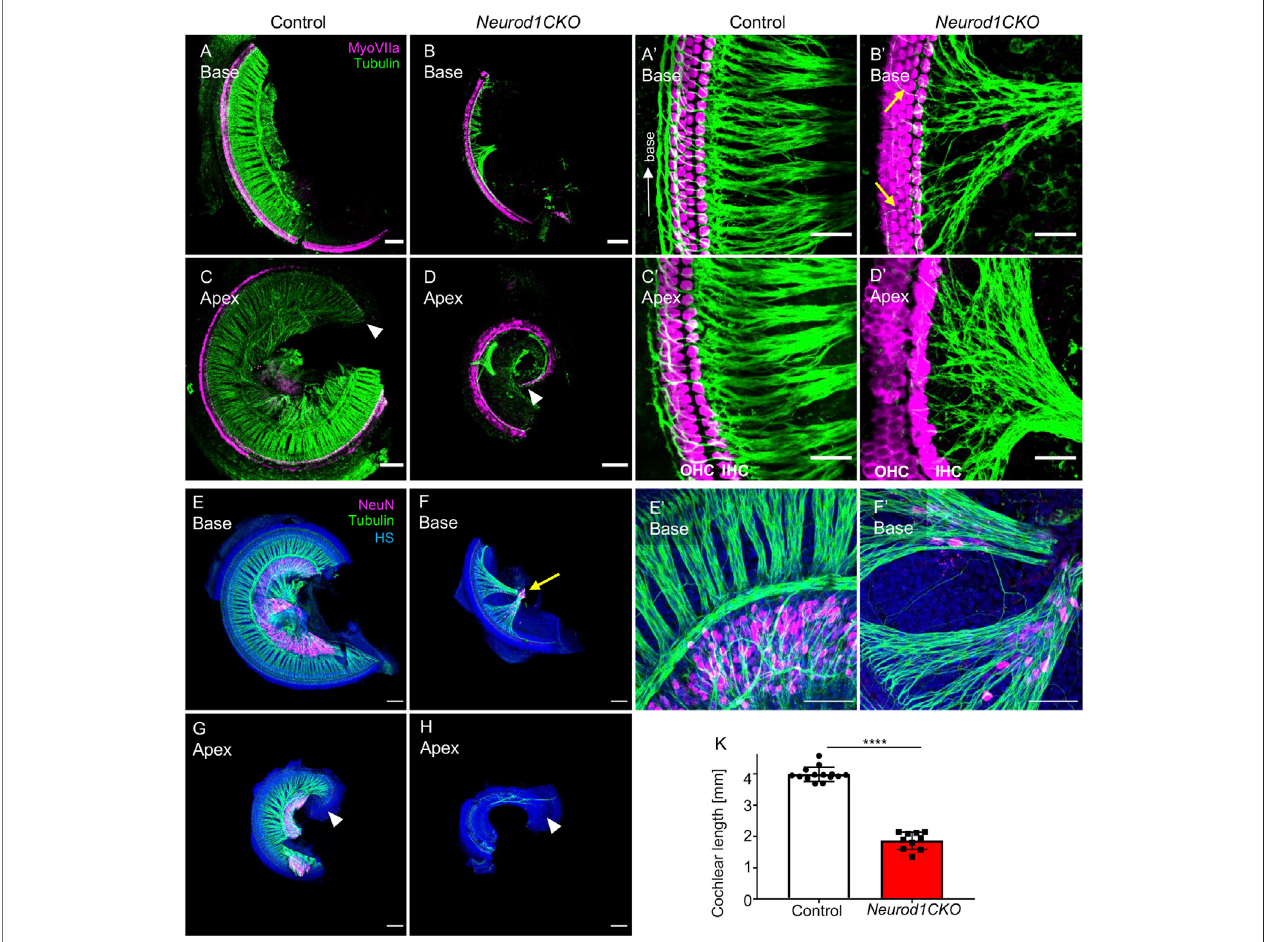
FIGURE2| Theeliminationof Neurod1 resultsintherudimentalspiralganglion,disorganizedsensoryepithelium,andtheshortenedcochlea. (A – D) Representative images of whole-mount immunolabeling of the cochlear base and apex with anti-MyosinVIIa (MyoVIIa, a marker of hair cells) and anti- α -tubulin (nerve fi bers) at E18.5. Arrowheadsindicatetheapicalend. (A ’ – D ’ ) Higher-magni fi cationimagesshowadensenetworkofradial fi bers,threerowsofouterhaircells(OHC),andonerowofinner hair cells (IHC), forming the organ of Corti in the control cochlea. Note the formation of parallel outer spiral bundles turned toward the base in the control cochlea (arrow in A ’ ). In Neurod1CKO , radial fi bers are severely reduced and disorganized, turning randomly towards the base or apex (arrows in B ’ ). The increased number of OHC rows in the apex indicates the disorganized sensory epithelium of the Neurod1CKO cochlea ( D ’ ). (E – H) The cochlea ’ s whole-mounted basal and apical half immunolabeledwithanti-NeuN(anuclearmarkerofdifferentiatedneurons)andanti-tubulin(nerve fi bers)showsNeuN + neuronsformingspiralganglionincontrolatP0.In contrast, only a small cluster of NeuN + neurons is found in the Neurod1CKO cochlea (arrow in F ). Note the reduced size of the cochlea and massive reduction of innervation. (E ’ , F ’ ) Higher-magni fi cation images of the base show the aberrant distribution of NeuN + neurons entangled with radial fi bers in Neurod1CKO compared to thespiralganglionneuronsrestrictedtotheRosenthal ’ scanalinthecontrolcochlea. (K) ThelengthoftheorganofCortiissigni fi cantlyshorterin Neurod1CKO compared to control littermates. Error bars represent mean ± SD; unpaired t- test, **** p ≤ 0.0001 ( n ≥ 5/genotype). Scale bars: 100 μ m (A – H) , 25 μ m (A ’– D ’ ) , 50 μ m (E ’ , F ’ ) . HS, Hoechst nuclear